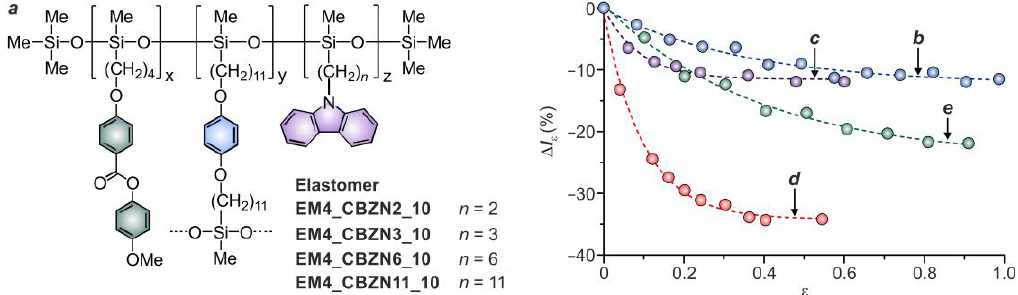
Figure 4. Chemical composition ( a ) and mechanofluorescent response for LSCEs EM4_CBZN2_10 ( b ), EM4_CBZN3_10 ( c ), EM4_CBZN6_10 ( d ) and EM4_CBZN11_10 ( e ) [57]. (Copyright from PCCP Owner Societies 2016).